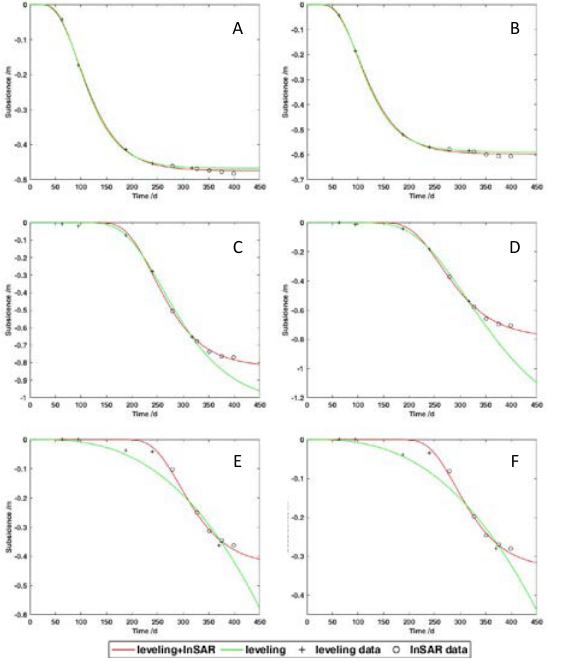
Figure 7. The fitted curves and levelling in six points As can be seen from Figure 7, the difference between the fitted curve obtained by levelling and InSAR with the curve only by levelling was much less in points A and B than that in other four points. The time of levelling was basically covered with three phase of mining-induced subsidence in points A and B, however, the levelling covered with the phase of initial and main subsidence in points C and D, the levelling data only covered with initial subsidence in points E and F. Therefore, the improvement of fitting accuracy was related to the InSAR data and the high precision fitting curve can be obtained by combining levelling measurements and InSAR observations.